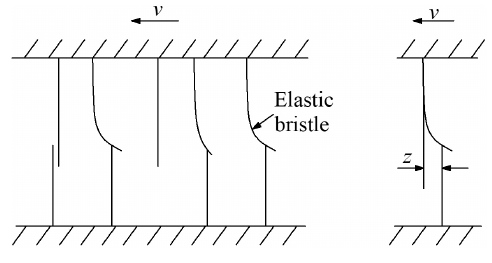
Figure 2. Bristle